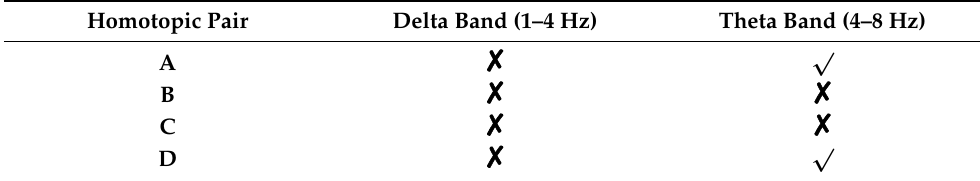
Table 2. Summary of the results of the post-hoc analysis of the LME regression. Homotopic Pair